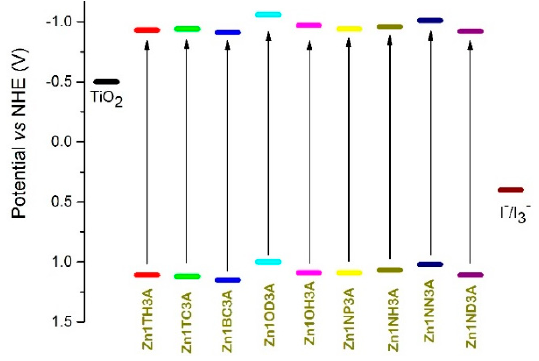
Figure 3. Energy level diagram for 1D ‐π‐ 3A porphyrin sensitizers.